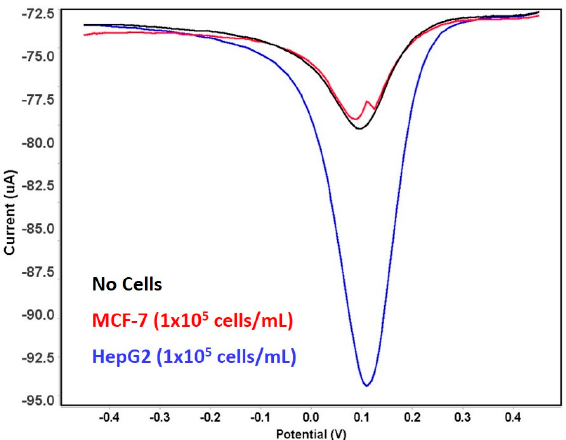
Figure 7. Square wave voltammograms of the developed sensor as a function of buffer (co cells) (black line), liver (HepG2) contains HOCs (blue line), and breast (MCF-7) (red line) cancer cell lines. Potential step: 5 mV; amplitude: 25 mV; frequency: 15 Hz.